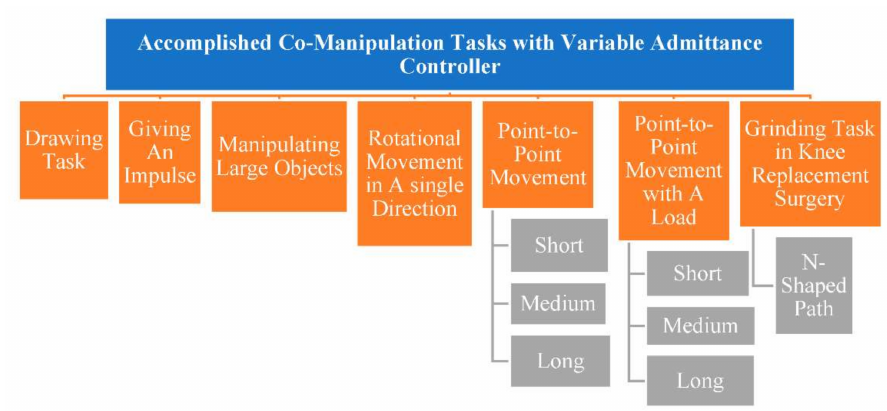
Figure 5. The robotic tasks accomplished during the development and the evaluation of the VA control that appeared in the